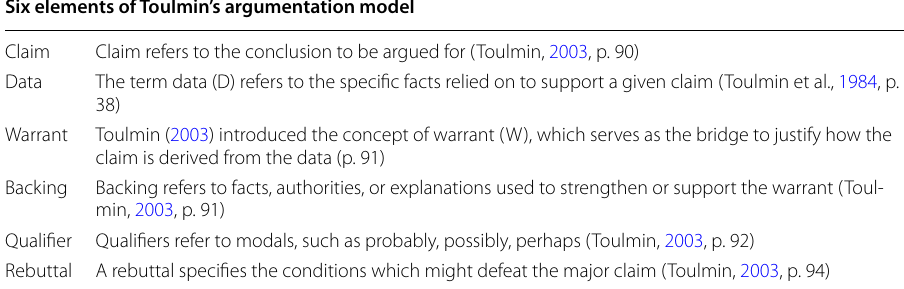
Table 3 Elements and definitions in the Toulmin model Six elements of Toulmin’s argumentation